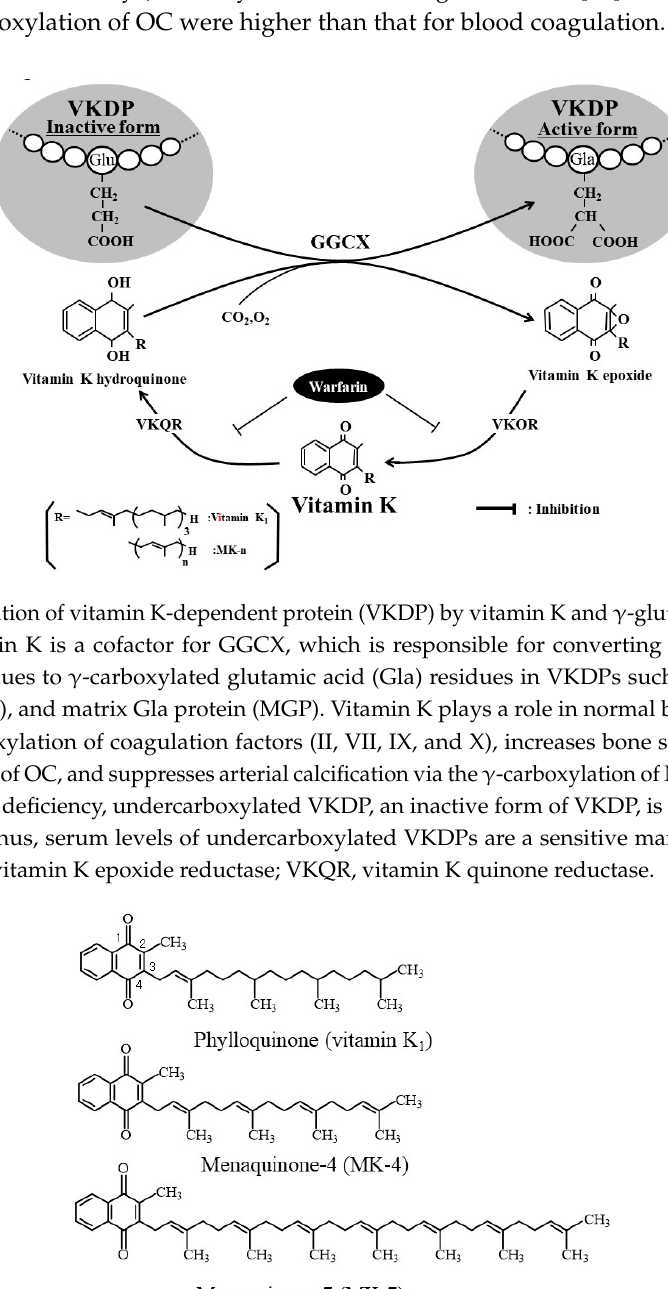
Figure 2. Chemical structures of vitamin K homologues. Vitamin K naturally exists in two forms, namely, phylloquinone (vitamin K 1 ) and menaquinones (MK-n, or vitamin K 2 ). Vitamin K homologues are characterized by a 2-methyl-1,4-naphthoquinone nucleus and a polyisoprenoid side chain at the 3-position that varies in both length and degree of saturation.